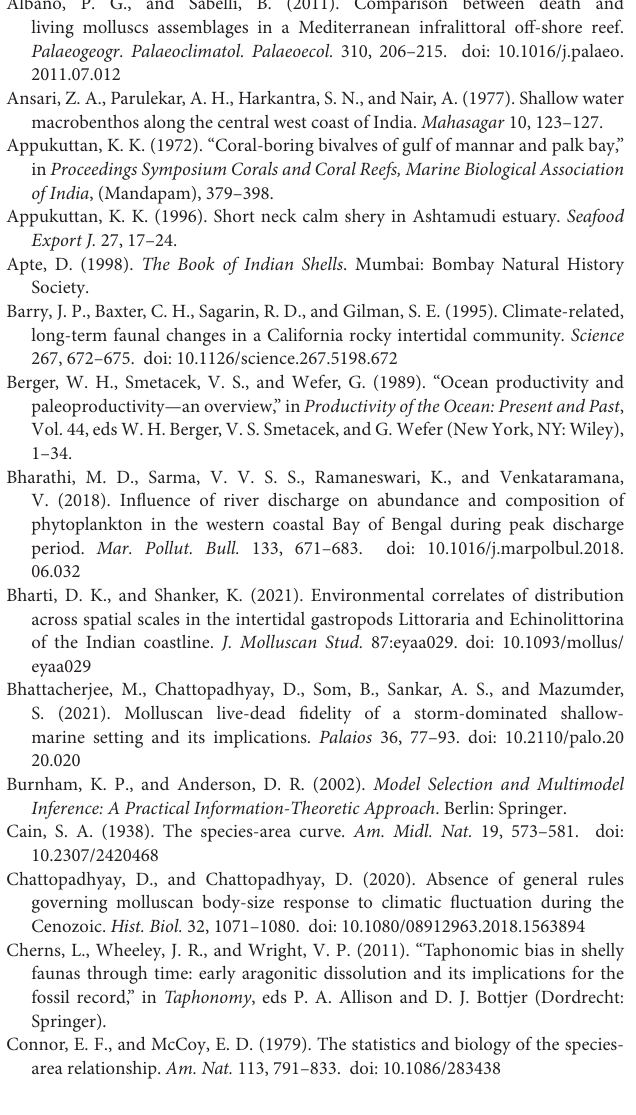
Supplementary Table 1 | Summary of Wilcoxon test comparing the proportion of various ecological types. The significant results are in bold. Supplementary Table 2 | Significance of Spearmann correlation test between environmental variables. The significant results are in bold. Supplementary Table 3 | Results of multiple GLM analyses to assess contribution of environmental variables in determining species richness,